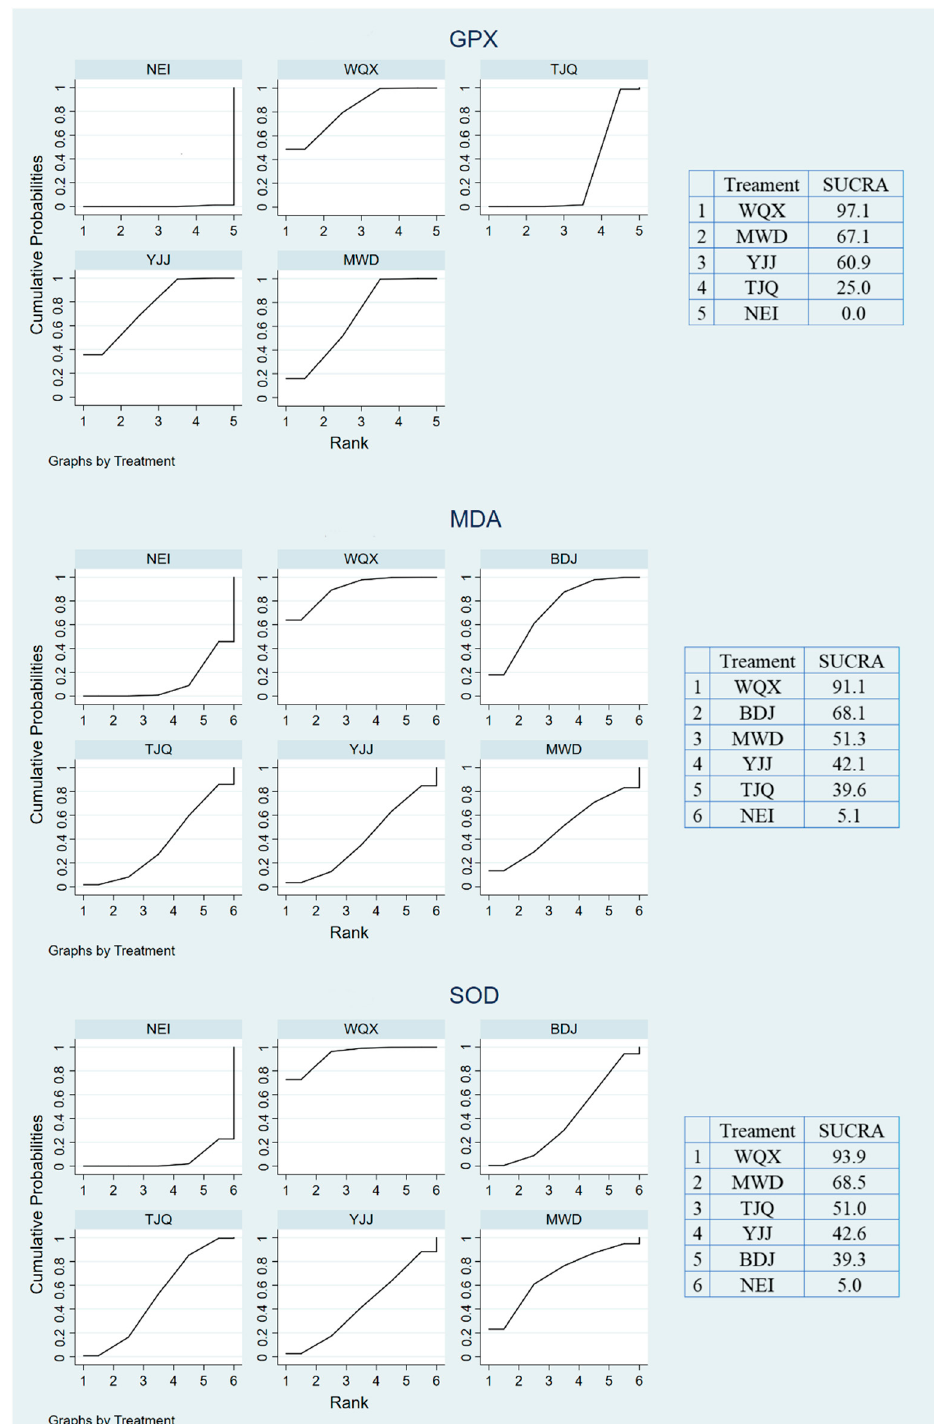
Figure 5. Results of the surface under the cumulative ranking and probability. (Notes: the table on the right shows the ranking of the best interventions. The area under the fold corresponds to the SUCRA value in the table on the right. The larger the SUCRA value, the more likely the intervention is to be the best choice; NEI, no exercise intervention; WQX, Wuqinxi; BDJ, Baduanjin; TJQ, Tai Ji Quan; YJJ, Yijinjing; MWD, Matangi Daoyin; GPX, glutathione peroxidase; MDA, malondialdehyde; SOD, superoxide